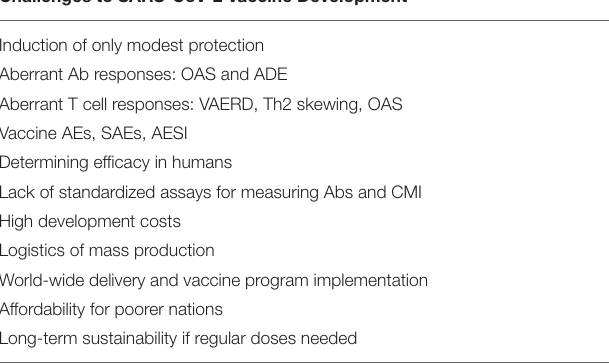
TABLE 4 | Some of the key challenges to successful SARS-CoV-2 vaccine development. Challenges to SARS-CoV-2 Vaccine